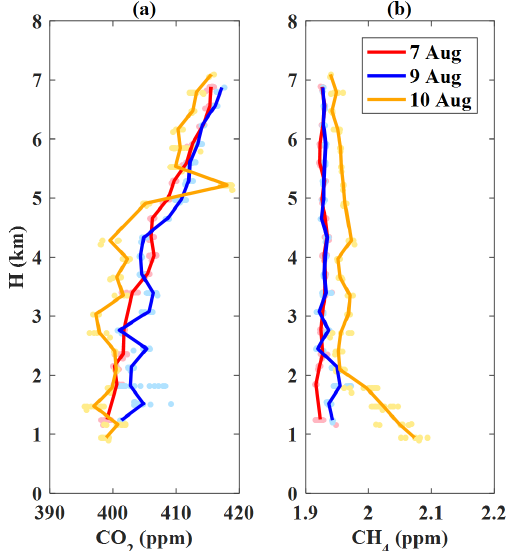
Figure 5. Vertical profiles of (a) CO 2 and (b) CH 4 observed on 7 (blue), 9 (red) and 10 (yellow) August 2018 over Jiansanjiang measured in situ with aircraft. The aircraft-based in situ measure- ment data are indicated with dots, and averaged data for each flat flight stage are shown as